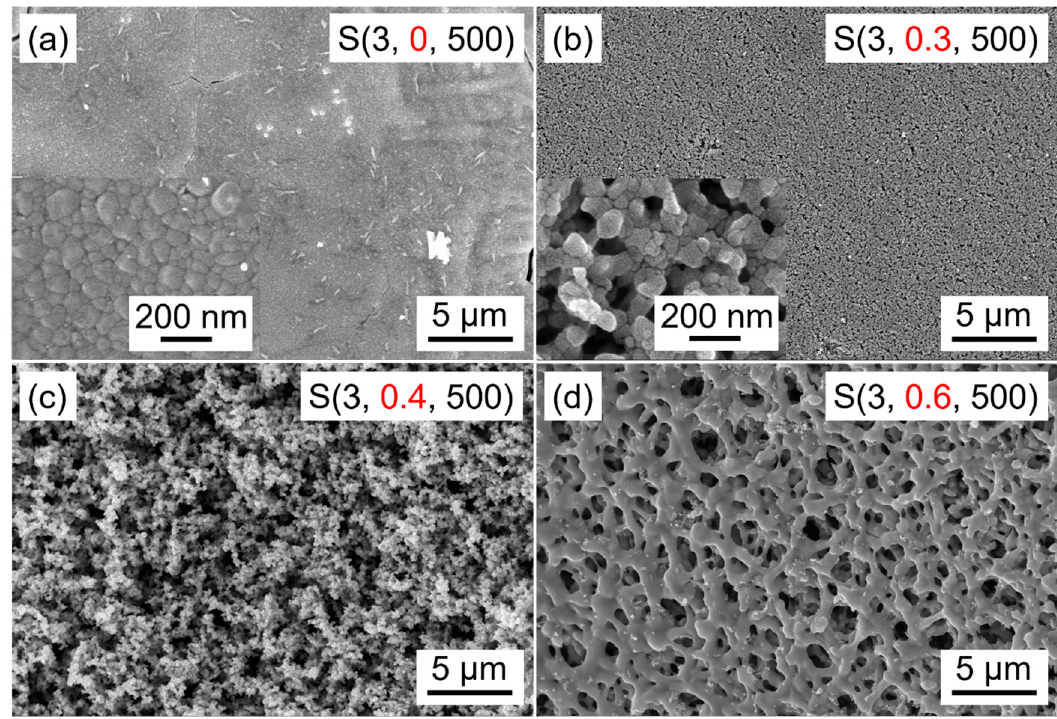
Figure 6. Scanning electron microscopy images of WO 3 films prepared at different PEG contents. ( a ) without PEG, ( b ) 0.3 g, ( c ) 0.4 g, ( d ) 0.6 g.